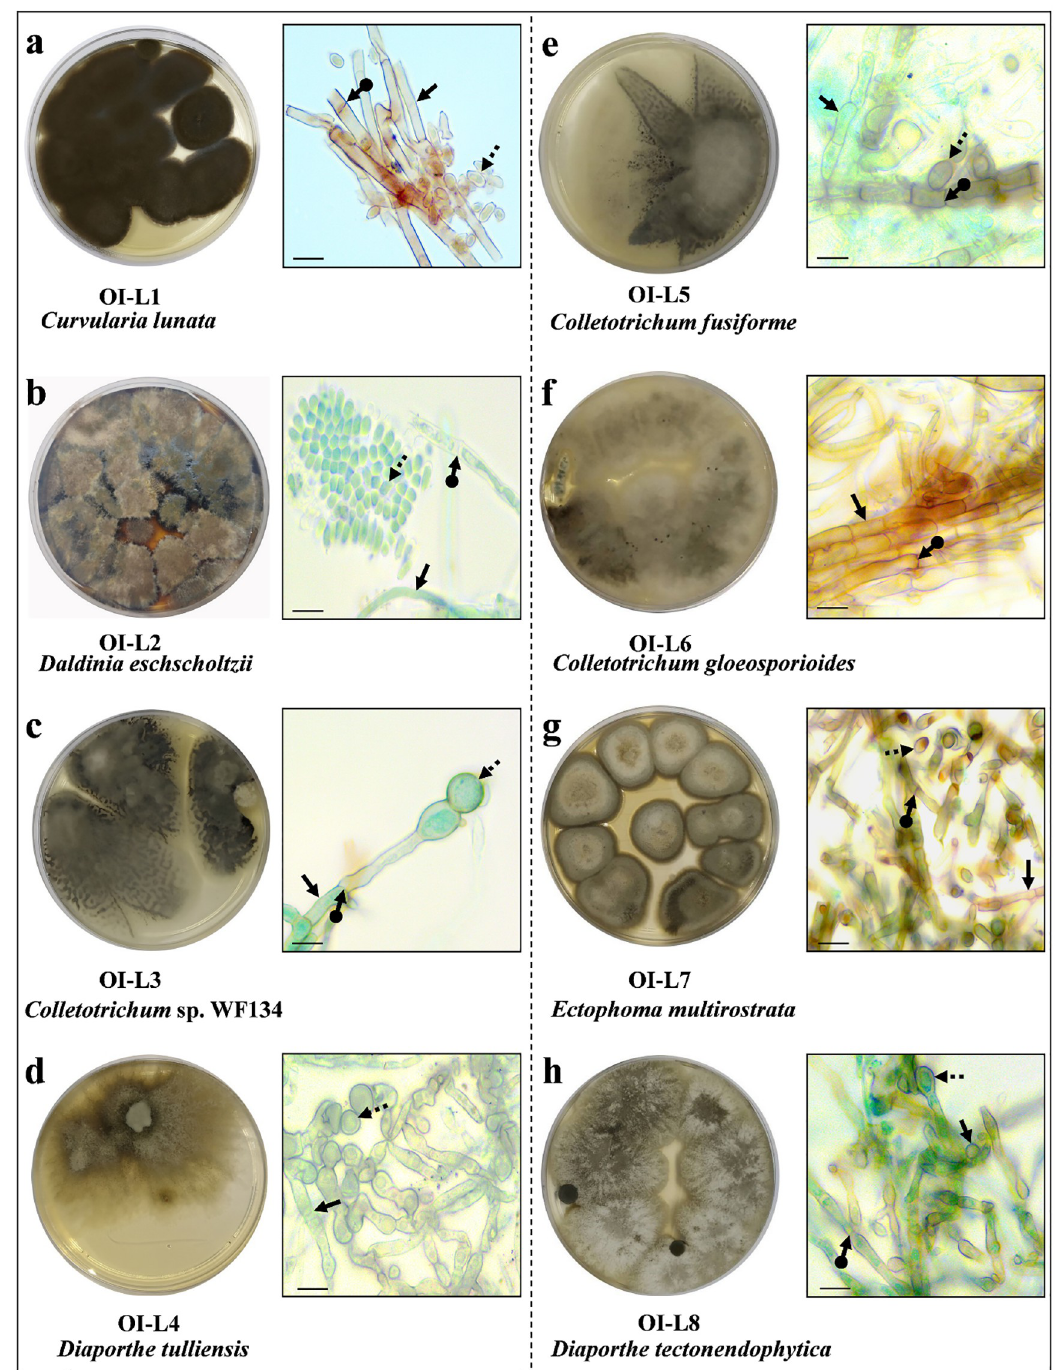
Fig 1. Photomicrograph showing the morphology of fungal colony on PDA plate after 10 days at 27 ± 2 ˚C, corresponding light microscope image of fungal endophytes (a) C . lunata , (b) D . eschscholtzii , (c) Colletotrichum sp. WF134, (d) D . tulliensis , (e) C . fusiforme , (f) C . gloeosporioides , (g) E . multirostrata and (h) D . tectonendophytica . Scale bar = 100 μ m.